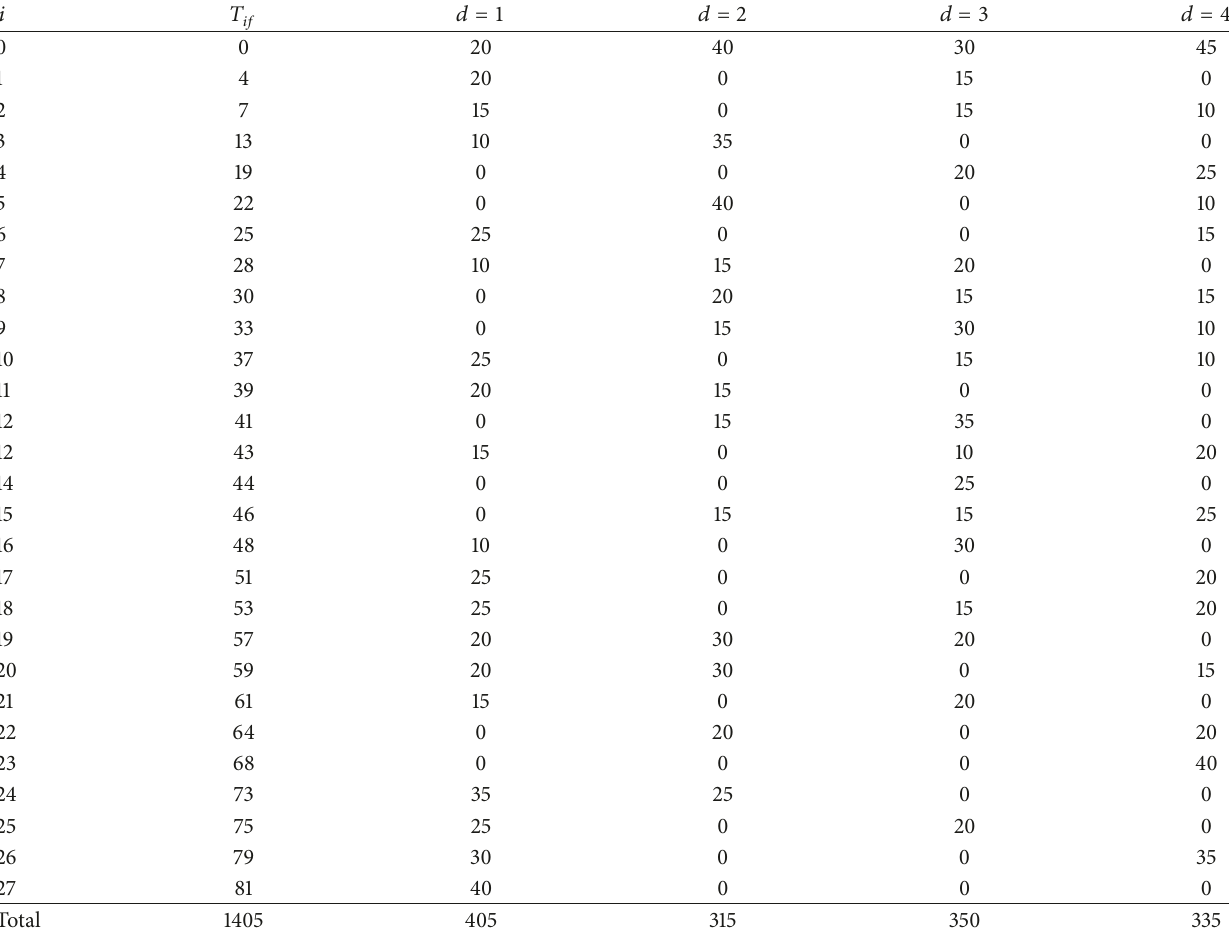
Table 1: Information of liner ships and containers in rail-water transhipping